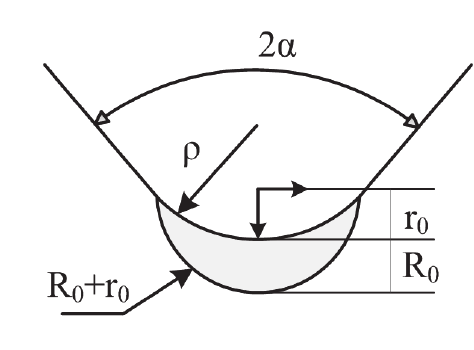
Figure 3: Definition of the control volume for specimens weakened by rounded